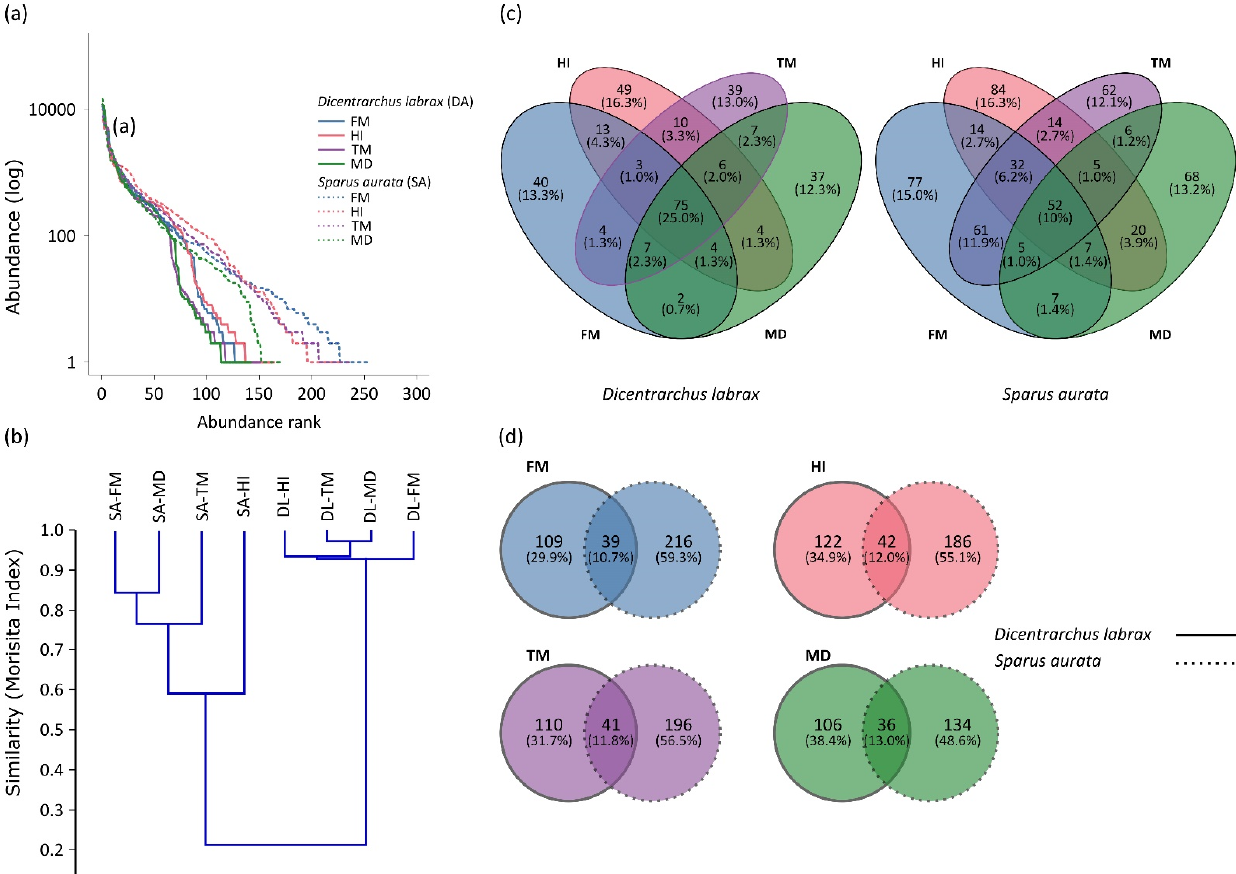
Figure 1. Gut microbiota of Dicentrarchus labrax and Sparus aurata fed control (FM: fish meal) and insect-containing diets (HI: Hermetia illucens ; TM: Tenebrio molitor ; MD: Musca domestica ). ( a ) Comparison of gut microbial community structure among the four dietary treatments in the two teleost species. Rank-abundance curves were constructed based on abundance derived from samples ( n = 12) for each diet. Curves for different diets and species are represented by different colors and lines, respectively. ( b ) Cluster analysis based on the Morisita similarity index of the bacterial operational taxonomic units (OTUs) derived from the gut of D. labrax and S. aurata fed control and insect-containing diets. Bootstrap analysis with 1000 replicates was conducted. ( c ) Venn diagrams displaying shared and unique bacterial OTUs between the four diets in D. labrax and S. aurata . ( d ) Venn diagrams displaying shared and unique bacterial OTUs between D. labrax and S. aurata fed the same diet. The percentages in the Venn diagrams indicate the respective ratios to the total number of bacterial OTUs.